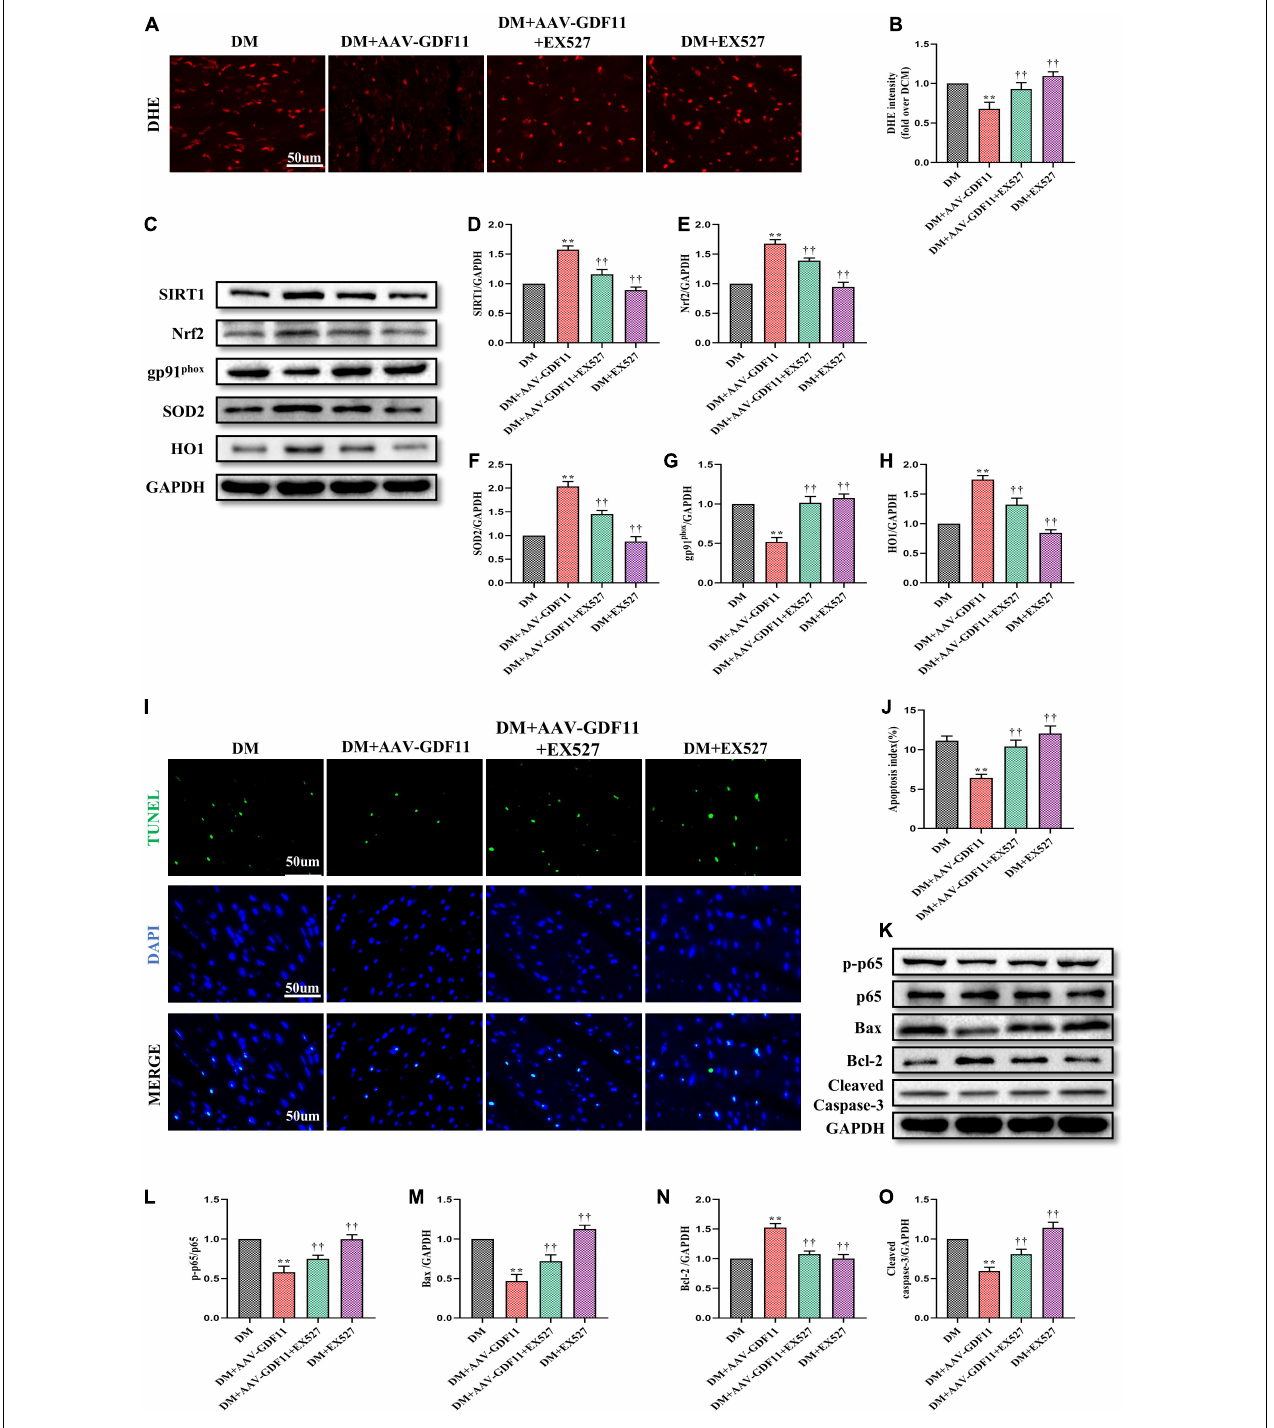
FIGURE 5 | SIRT1 inhibition abolished the antioxidative and antiapoptotic functions of GDF11 in diabetic cardiomyopathy (DCM). (A) Representative images of dihydroethidium (DHE) staining (scale bar = 50 µ m). (B) DHE fluorescence intensities. (C) Representative blots of SIRT1, Nrf2, gp91 phox , SOD2, and HO1. (D) Quantitative expression of SIRT1. (E) Quantitative expression of Nrf2. (F) Quantitative expression of gp91 phox . (G) Quantitative expression of SOD2. (H) Quantitative expression of HO1. (I) Representative images of TUNEL staining (scale bar = 50 µ m). (J) Apoptotic ratio. (K) Representative blots of p-p65. p65, Bax, Bcl-2, and Cleaved Caspase-3. (L) Quantitative analysis of the ratio of p-p65 to p65. (M) Quantitative expression of Bax. (N) Quantitative expression of Bcl-2. (O) Quantitative expression of Cleaved Caspase-3. Data are presented as the mean ± SEM, n = 5 or 6 per group. ** P < 0.01 versus the DM group, †† P < 0.01 versus the DM + AAV-GDF11